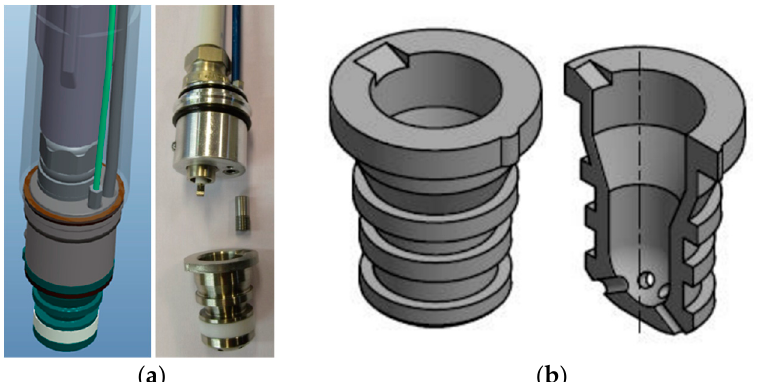
Figure 5. Solutions of direct gas supply system to the prechamber: ( a ) spark plug and a return valve system [32]; ( b ) the prechamber used in the current study. Table 1. Technical specifications of the prechamber used in research.